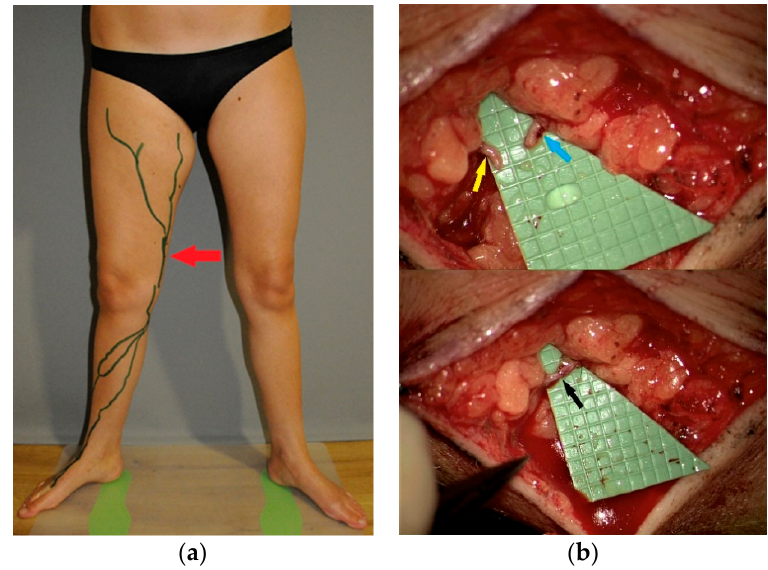
Figure 4. ( a ) Patent lymphatic vessels identified by indocyanine green (ICG) lymphography are marked on the skin. The site of incision is marked by an arrow. ( b ) Exposure of the lymphatic vessel (yellow arrow) and the vein (blue arrow) with diameters of 0.5 mm and 0.6 mm, respectively, through a 3 cm skin incision (higher panel) prior to the lymphovenous anastomosis (black arrow, lower panel).